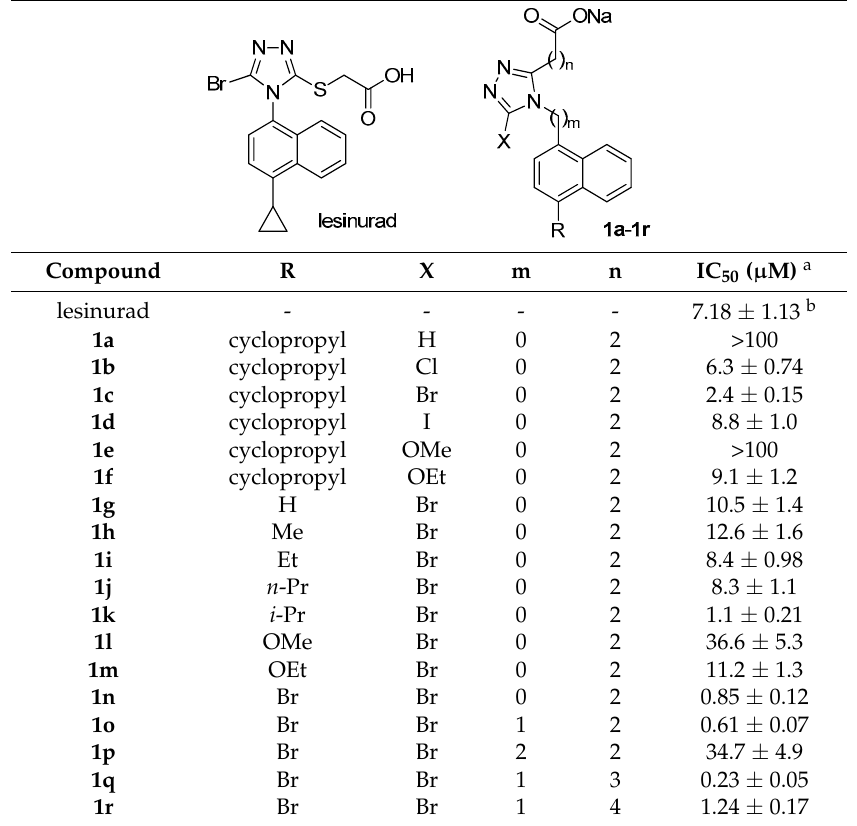
Molecules 2016 , 21 , 1543 Table 1. In vitro inhibitory activity of 1a – 1r as well as lesinurad against human URAT1 (IC 50 ).